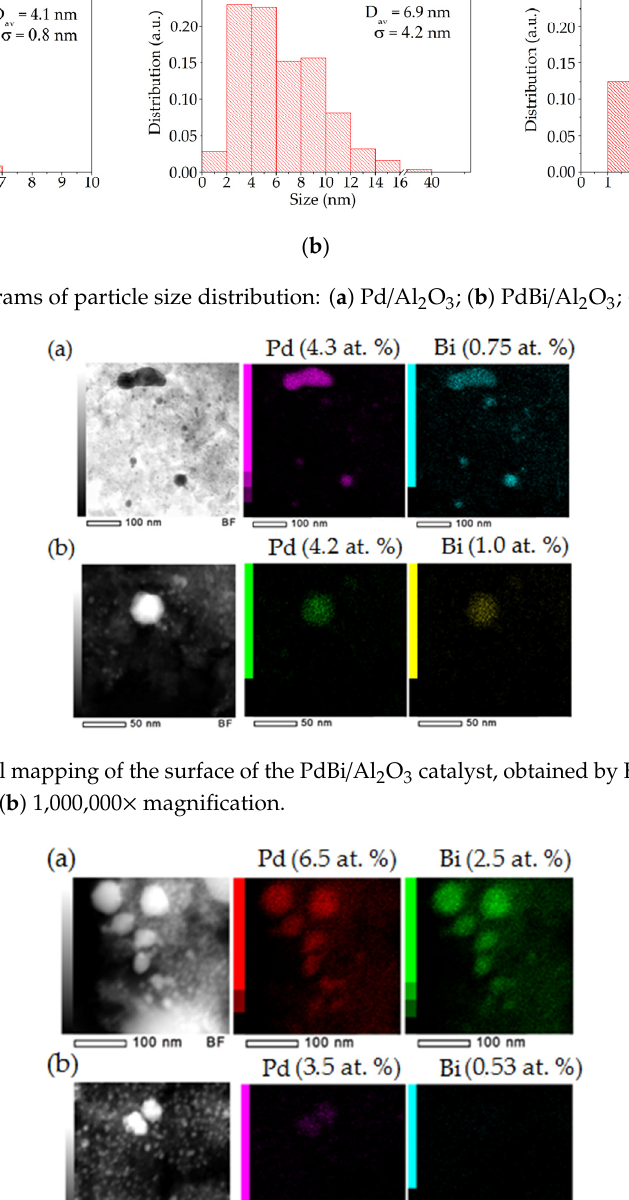
( c ) Figure 1. TEM-microphotographs of samples: ( a ) Pd/Al 2 O 3 ; ( b ) PdBi/Al 2 O 3 ; ( c ) Pd → Bi/Al 2 O 3 . For the Pd/Al 2 O 3 monometallic catalyst, a narrower particle size distribution is observed as compared to samples of bimetallic catalysts. The particle sizes of the Pd/Al 2 O 3 sample are in the range of 2–7 nm. For the PdBi/Al 2 O 3 catalyst sample obtained by combined impregnation, small